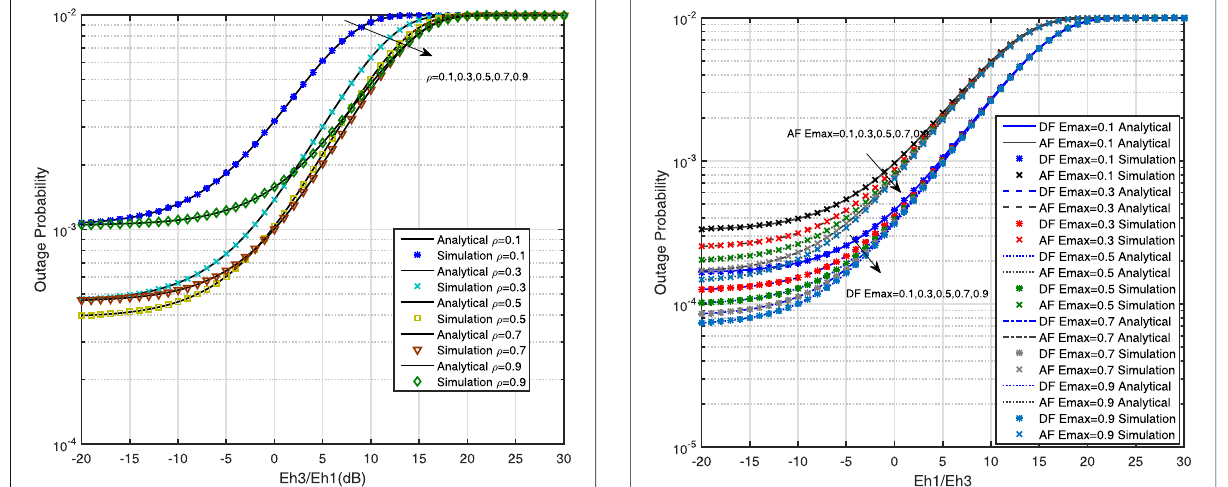
Fig. 5 Outage probability versus E h 1 for E max with DF and